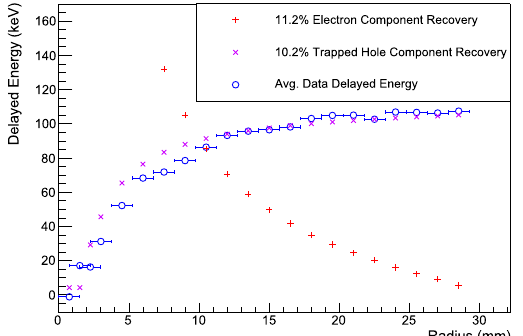
Fig. 13 The results of siggen simulations of energy loss ( a ) and delayed charge recovery ( ◦ ) of events occurring on the passivated sur- face. The average values of spectral/DCR distribution fits to the data are given by blue circles, with blue boxes indicating the α event energy range in cases where the peak position does not adequately capture the distribution shape incomplete electron-hole component collection. Future